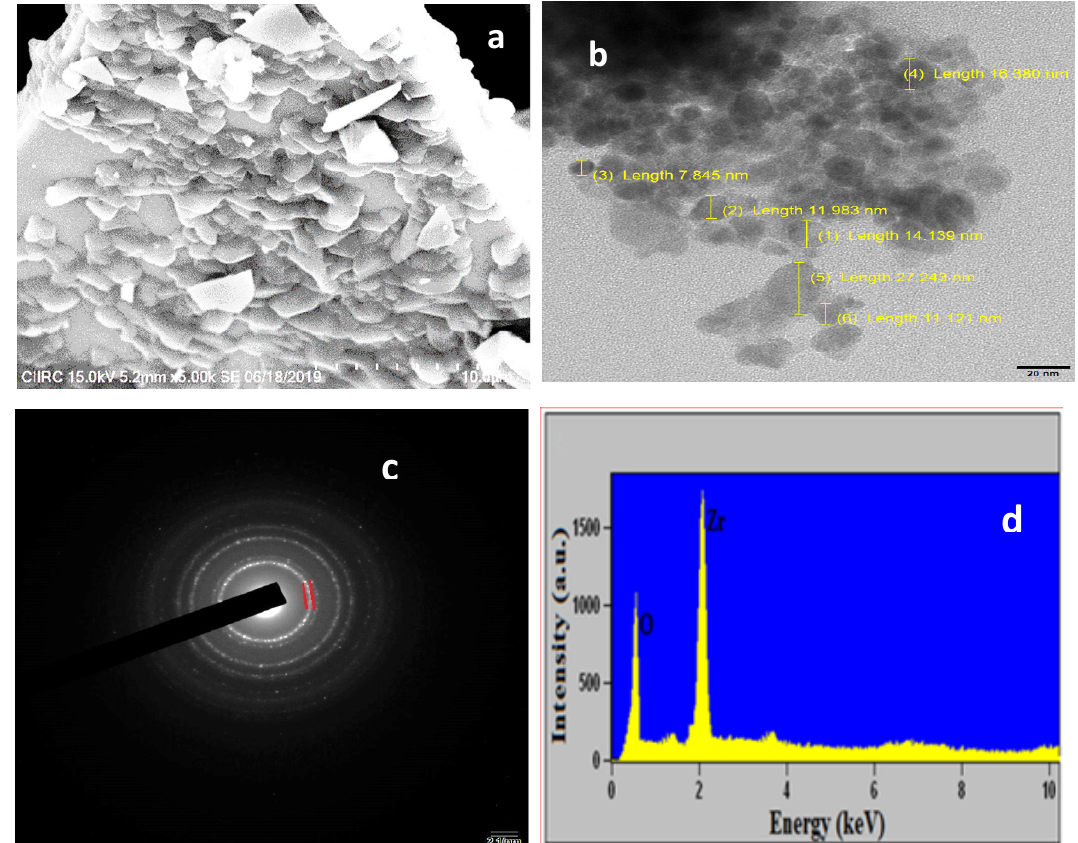
Fig. 3. (a) SEM images showing flaky surface, (b) TEM images (c) SAED pattern and (d) EDS spectrum of pure Zr, O elements